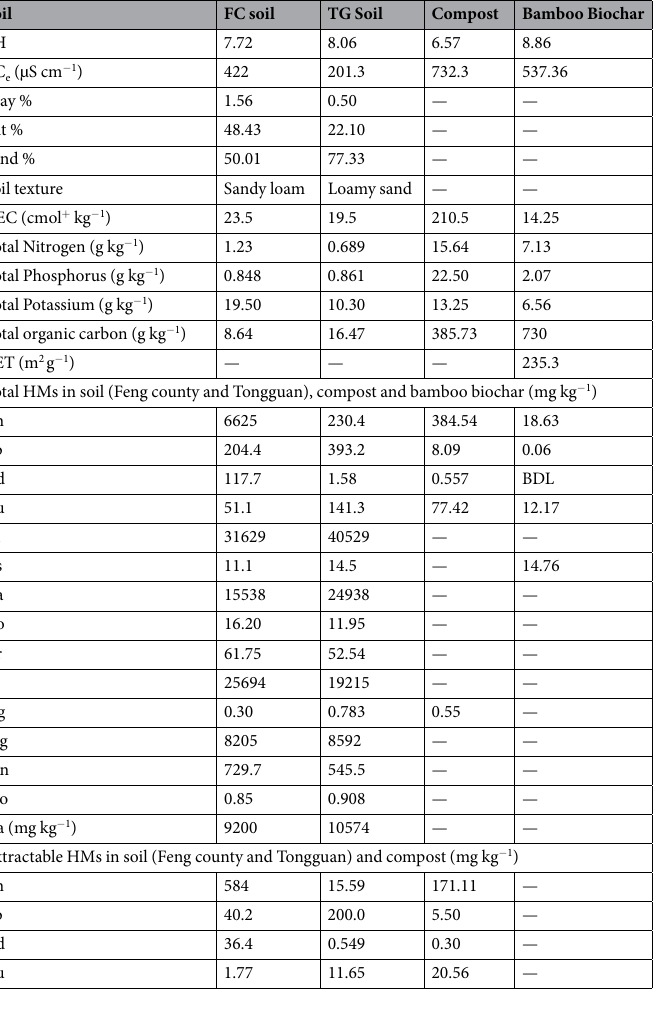
Table 1. Main characteristics of mine contaminated soils, compost and bamboo biochar. * Values indicate mean of one sample with three replications. BDL indicates values below detection